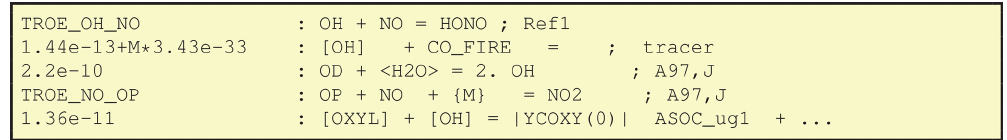
Figure 5. Selected lines from the input file GenIn_Reactions.txt .